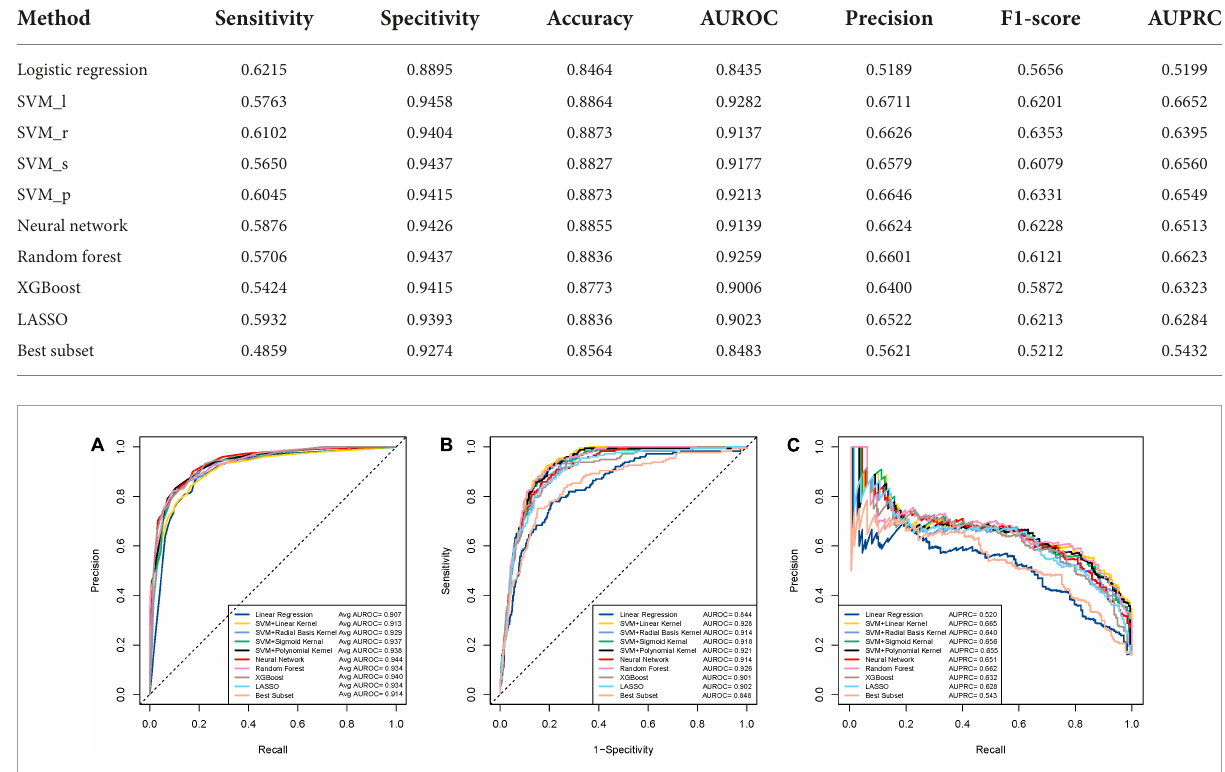
FIGURE5 ROC and PRC curves for the machine learning models for detecting dementia. (A) Mean ROC curves for the models on the nursing datasets. Each curve represents the mean ROC curve from the outer loop of the double cross validation. (B) ROC curves for the models on the community data. (C) PRC curves for the models on the community